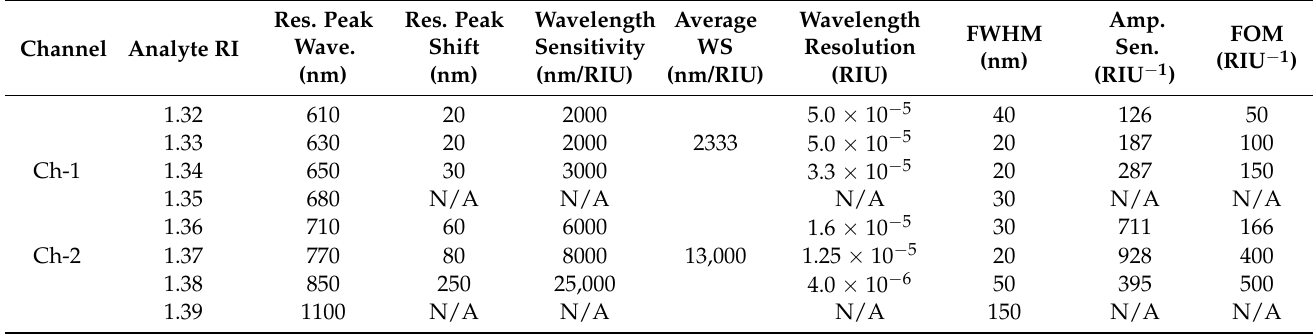
Table 1. Performance overview of the proposed multi-channel PCF-based SPR sensor. Res. Channel Analyte RI